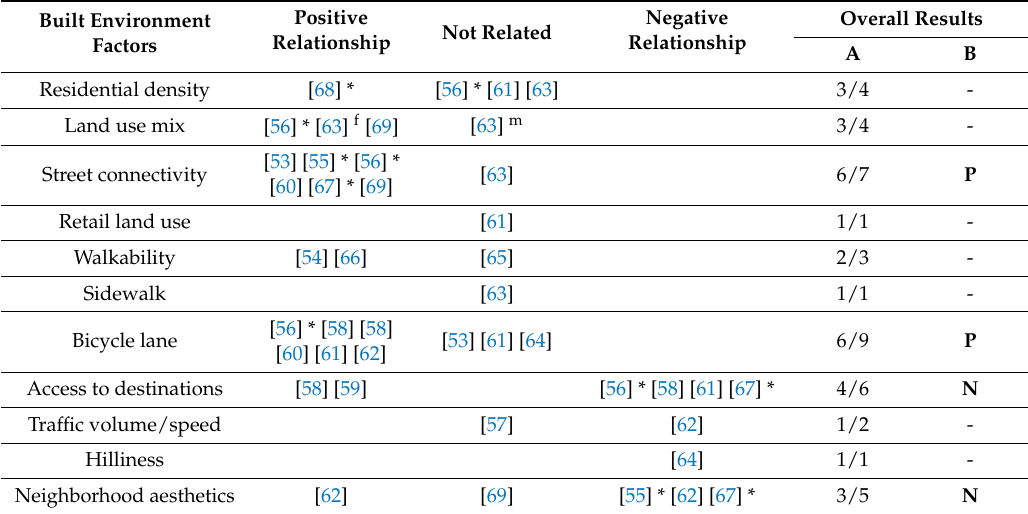
Table 7. Summary of relationships between built environment and cycling for